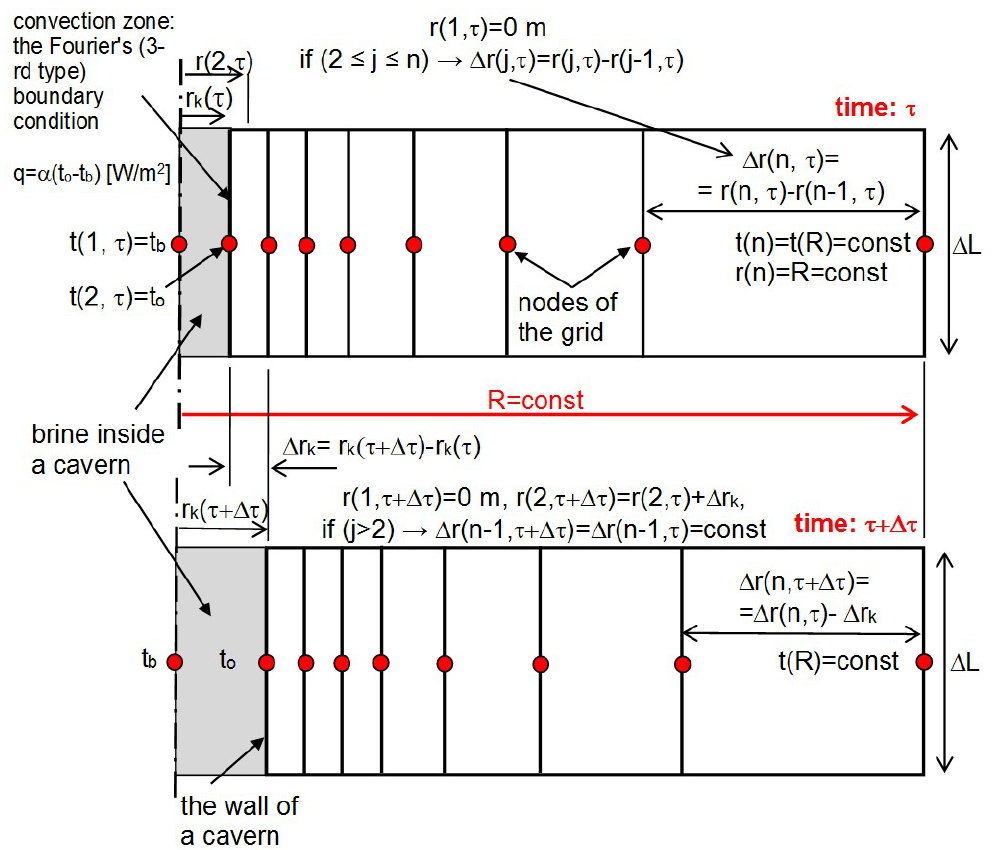
Figure 3. Space discretization and boundary conditions